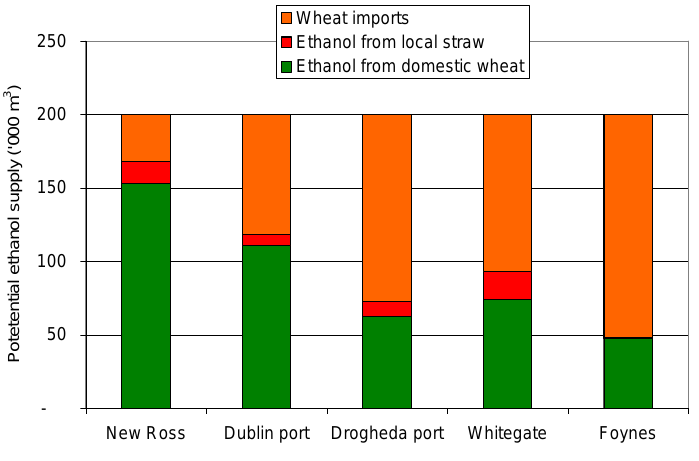
Figure 8. Modeled production of ethanol from the potential feedstock of domestic wheat and straw and required imports for port